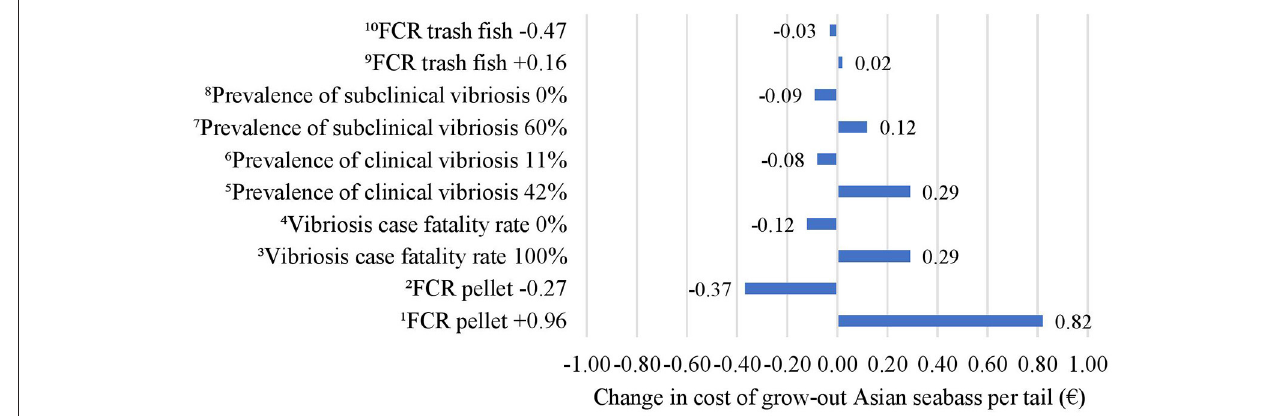
FIGURE 3 | Impact of change in biological inputs on the costs of grow-out in Asian seabass per tail. 1 When the FCR for pellet increases by 0.96 from its default value, the costs of grow-out increase by e 0.82 per tail. 2 When the FCR for pellet decreases by 0.27 from its default value, the costs of grow-out decrease by e 0.37 per tail. 3 When the case fatality rate due to vibriosis is 100%, the costs of grow-out increase by e 0.29 per tail. 4 When the case fatality rate due to vibriosis is 0%, the costs of grow-out decrease by e 0.12 per tail. 5 When the prevalence of clinical vibriosis is 42%, the costs of grow-out increase by e 0.29 per tail. 6 When the prevalence of clinical vibriosis is 11%, the costs of grow-out decrease by e 0.08 per tail. 7 When the prevalence of subclinical vibriosis is at 60%, the costs of grow-out increase by e 0.12 per tail. 8 When the prevalence of subclinical vibriosis is at 0%, the costs of grow-out decrease by e 0.09 per tail. 9 When FCR for trash fish increases by 0.16, the costs of grow-out Asian seabass increase by e 0.02 per tail. 10 When FCR for trash fish decreases by 0.47, the costs of grow-out decrease by e 0.03 per tail.